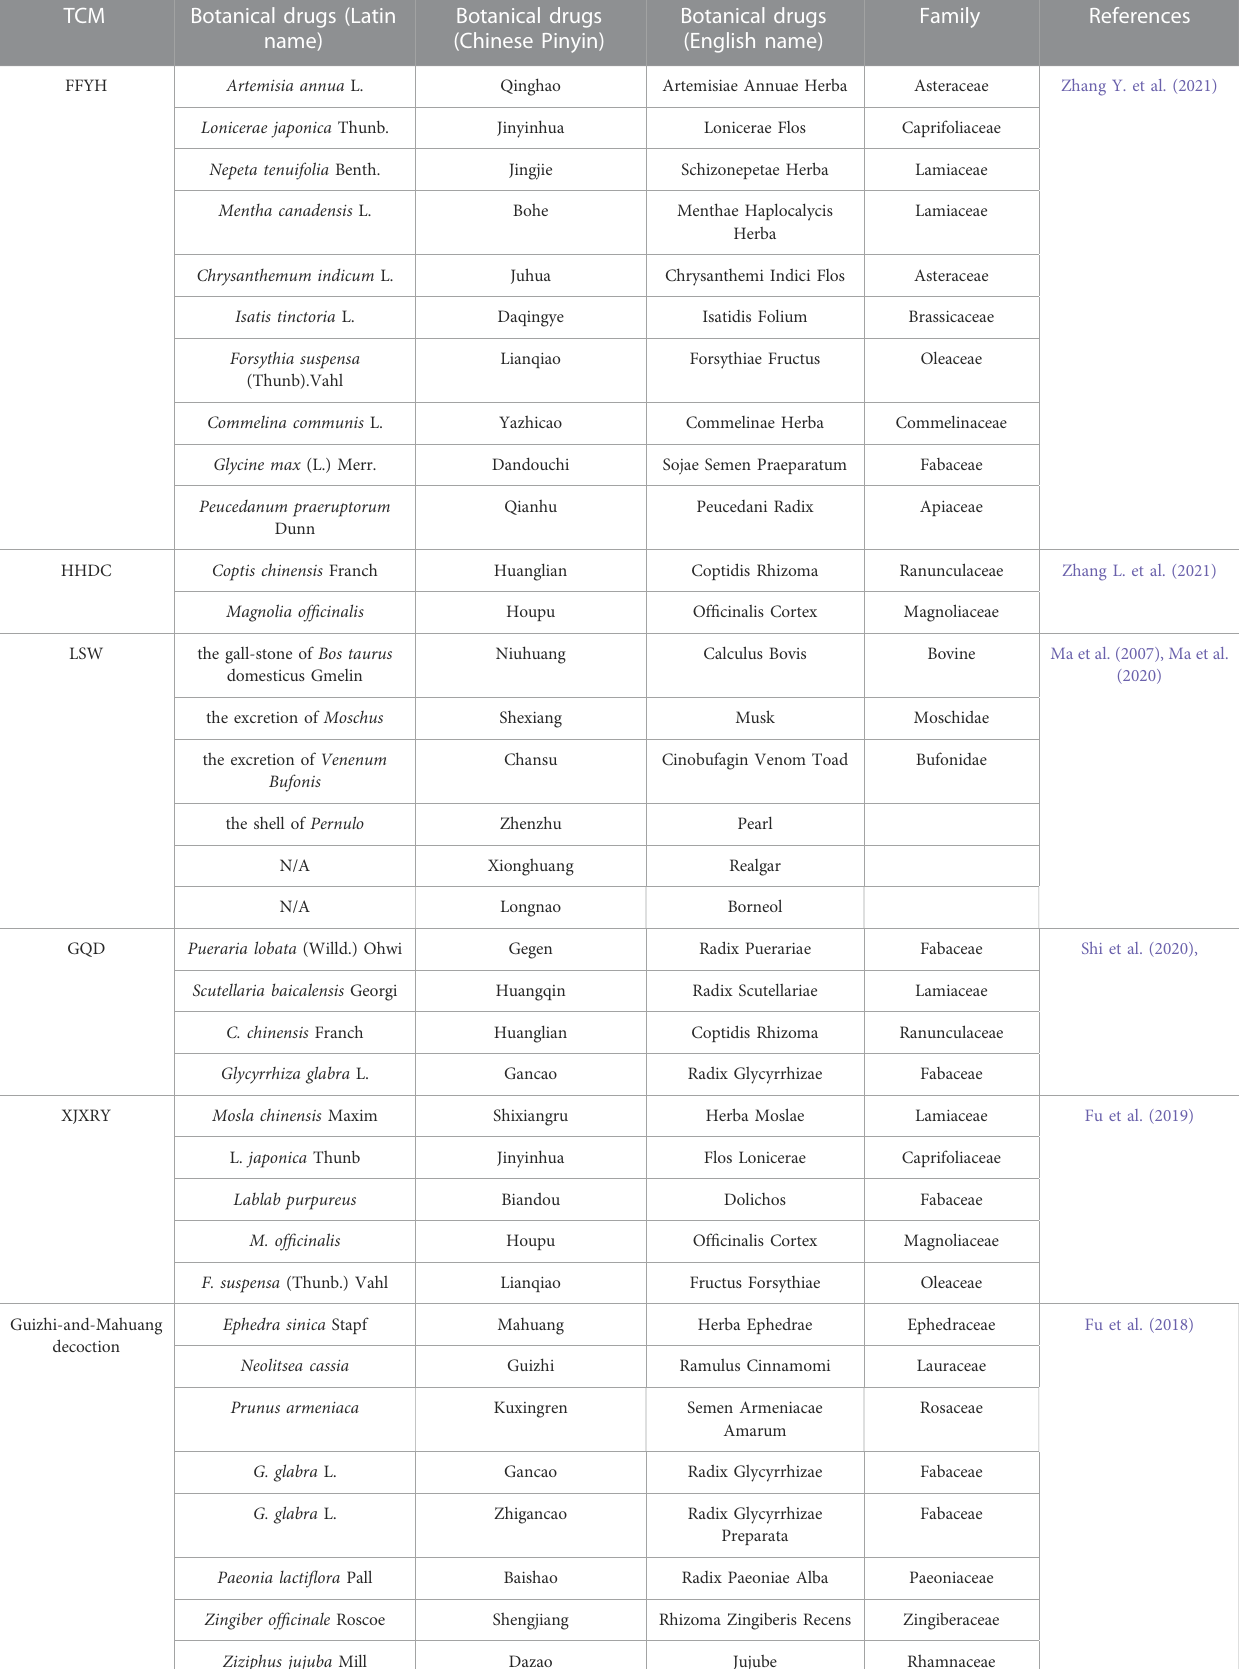
TABLE 3 The composition of formulae and single-active-ingredients of TCM.